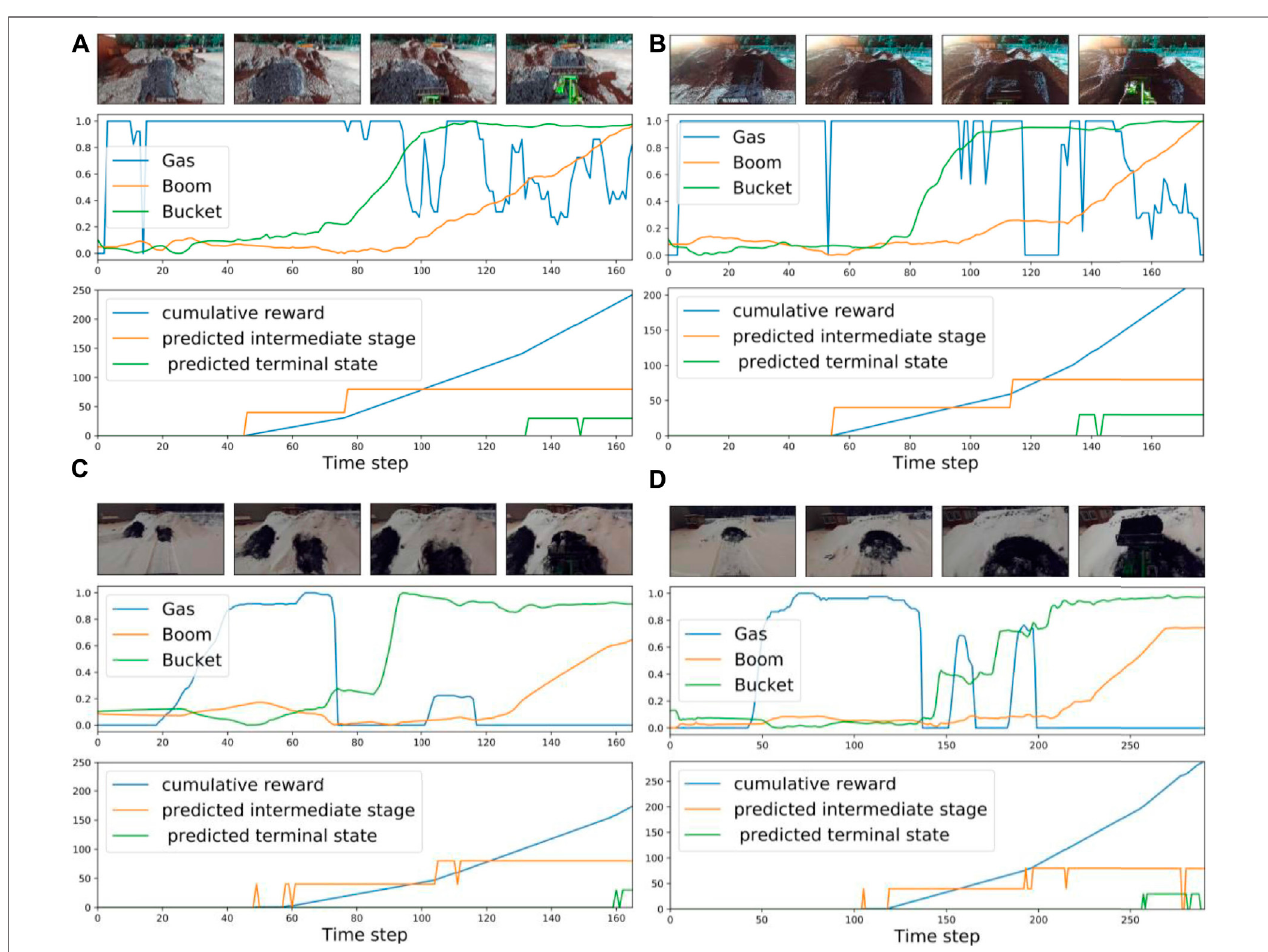
FIGURE 8 | Examples of proposed cumulative reward based on the discovered stages: (A,B) summer, different light conditions, (C,D) winter, different locations.